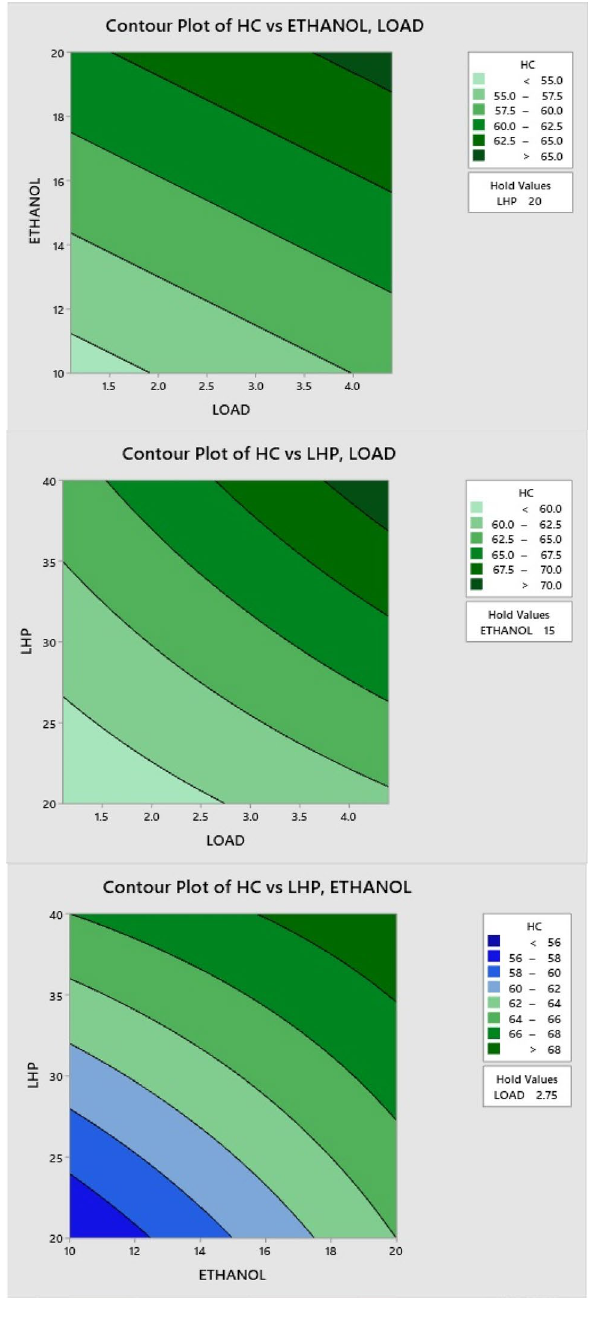
Figure 13. Effect of LHP and ethanol blend ratio on